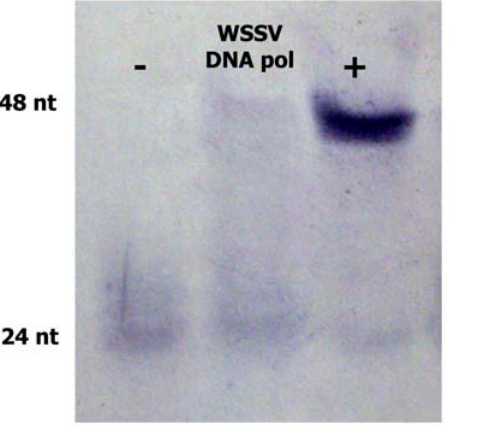
Figure 4. Polymerase activity of the recombinant WSSV DNA pol. WSSV DNA pol was tested in a nucleotide incorporation assay (central lane). The Klenow fragment was the positive control (lane +). A reaction without polymerase was ran as negative control